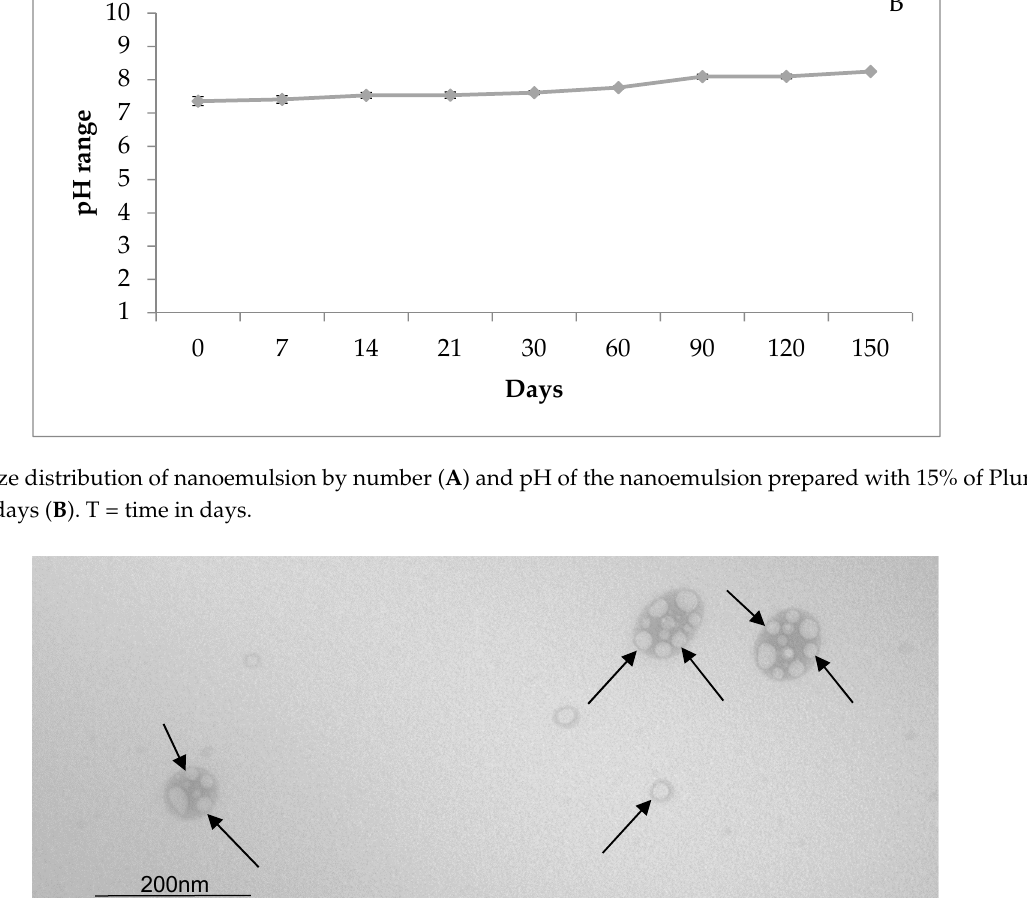
Figure 2. Size distribution of nanoemulsion by number ( A ) and pH of the nanoemulsion prepared with 15% of Pluronic ® F-127 over days ( B ). T = time in days.